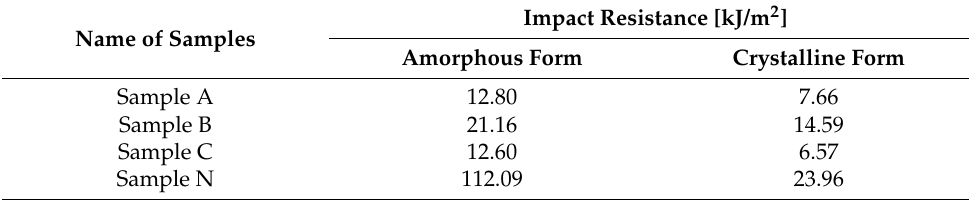
Table 5. Results of impact testing for each